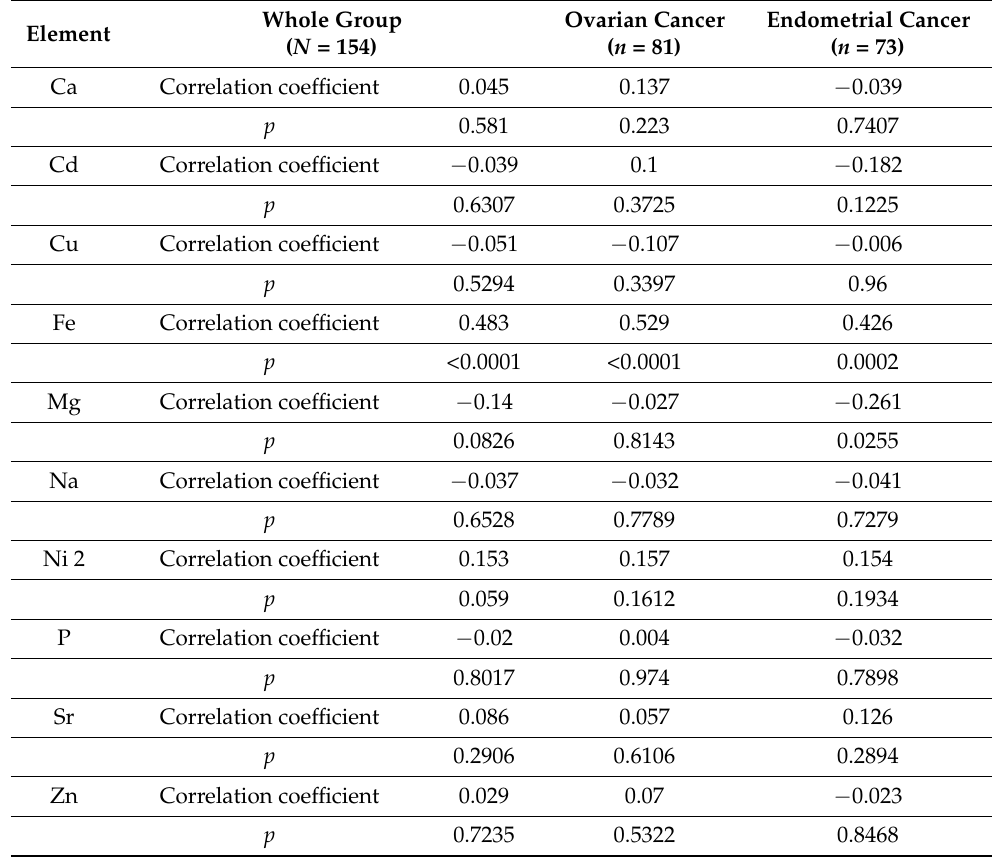
Ovarian Cancer Endometrial Cancer ( n = 81) ( n = 73)